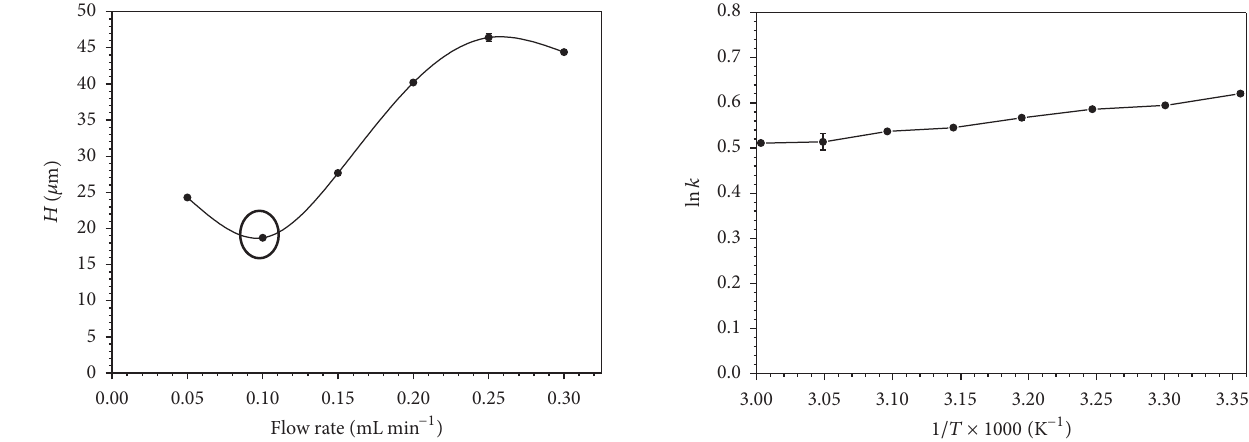
Figure 1: Van Deemter curve for MDA. The conditions were as fol- lows: UPLC C 18 column; isocratic elution, mobile phase containing acetonitrile-water with 0.1% (v/v) formic acid; temperature 25 ∘ C; MDA concentration 100 𝜇 g L −1 ; injection volume 10 𝜇 L.